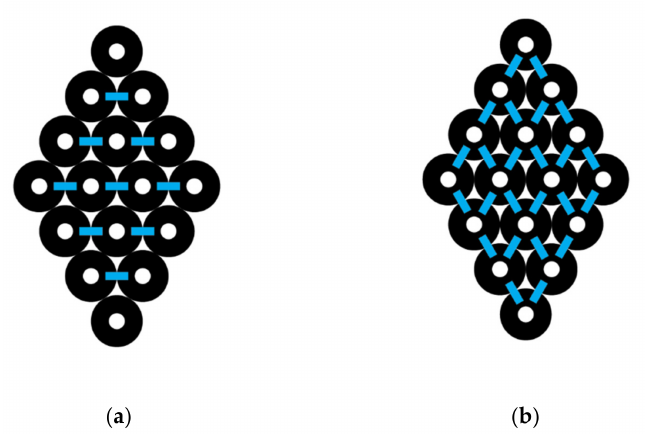
Figure 3. A diamond-shaped CNT bundle: ( a ) pair interactions oriented across and ( b ) pair interac- tions oriented